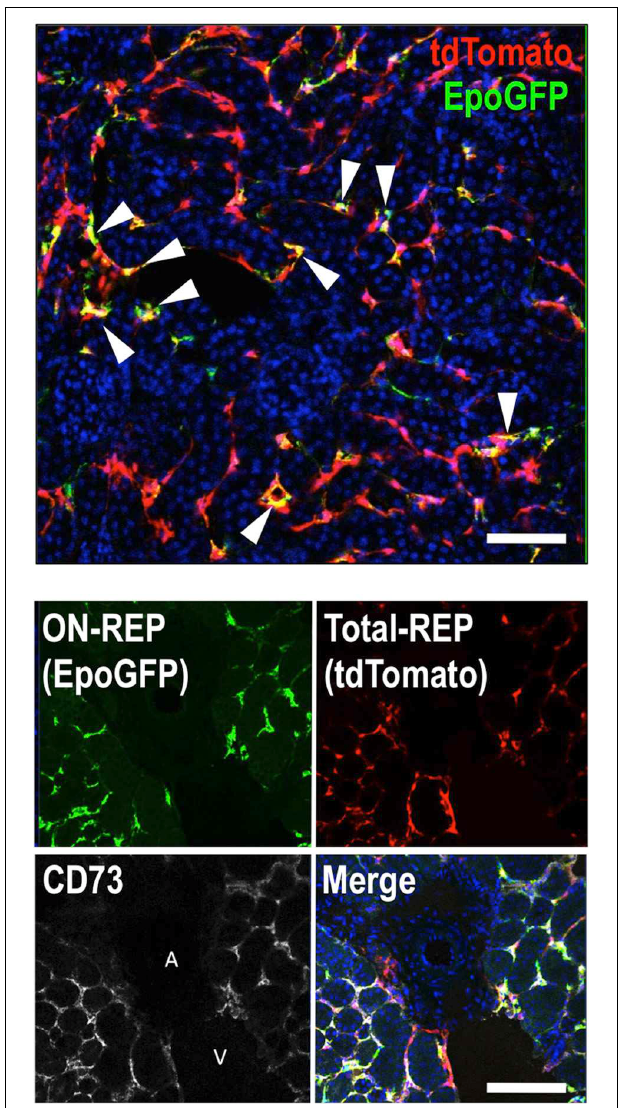
FIGURE 1 | REPs are peri-capillary CD73-positive fibroblast-like cells. A kidney section from ISAM-REC (ISAM:R26RtdTomato:Tg-EpoCre) shows ON-REPs expressing EpoGFP (arrowheads, positive for both green and red) in the total REP population (positive for tdTomato fluorescence, red). The nuclei are stained by DAPI (blue). A kidney section from ISAM-REC shows that REPs or CD73-positive fibroblasts are distributed in peri-capillary interstitial spaces but not in peri-arterial interstitial areas of the kidneys. DAPI (blue) is used for nuclear staining in the merged image. Abbreviations: A, artery; V, vein. Scale bar, 100 µ